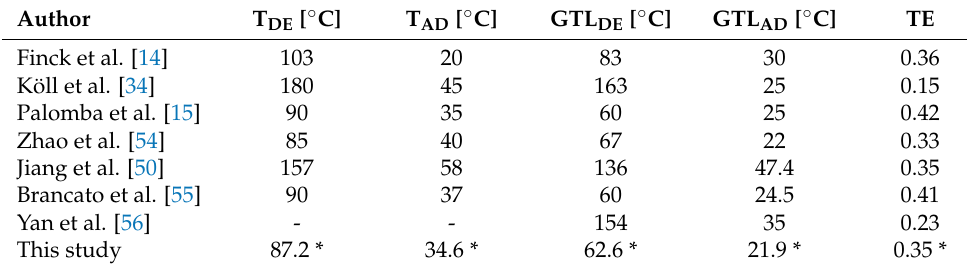
Table 12. TE of different close fixed sorption systems. Adapted from